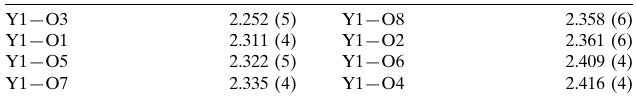
Selected bond lengths (A˚